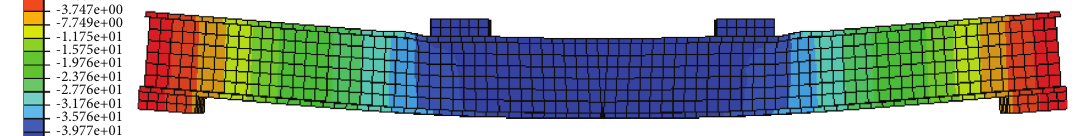
Figure 12: Deflection image.